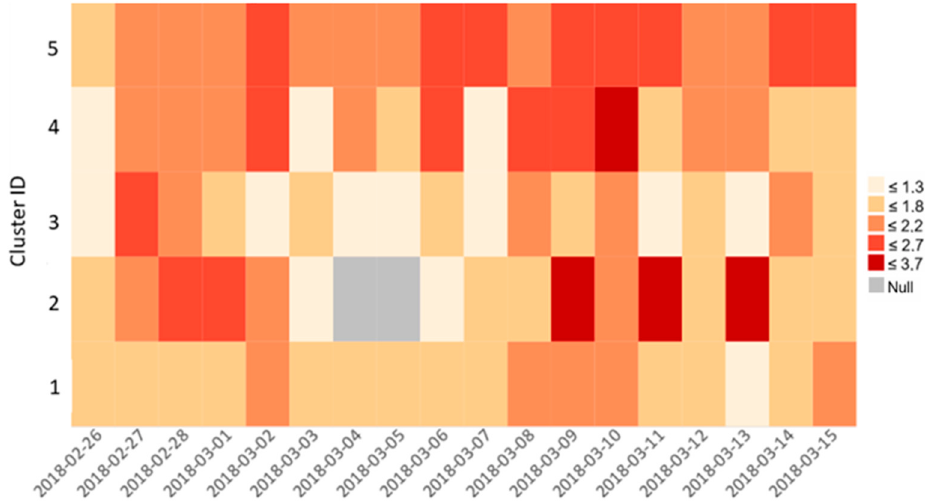
Figure 7. Sentiment values per day for each cluster (identified in Section 4.2)—RQ2a and RQ3a.